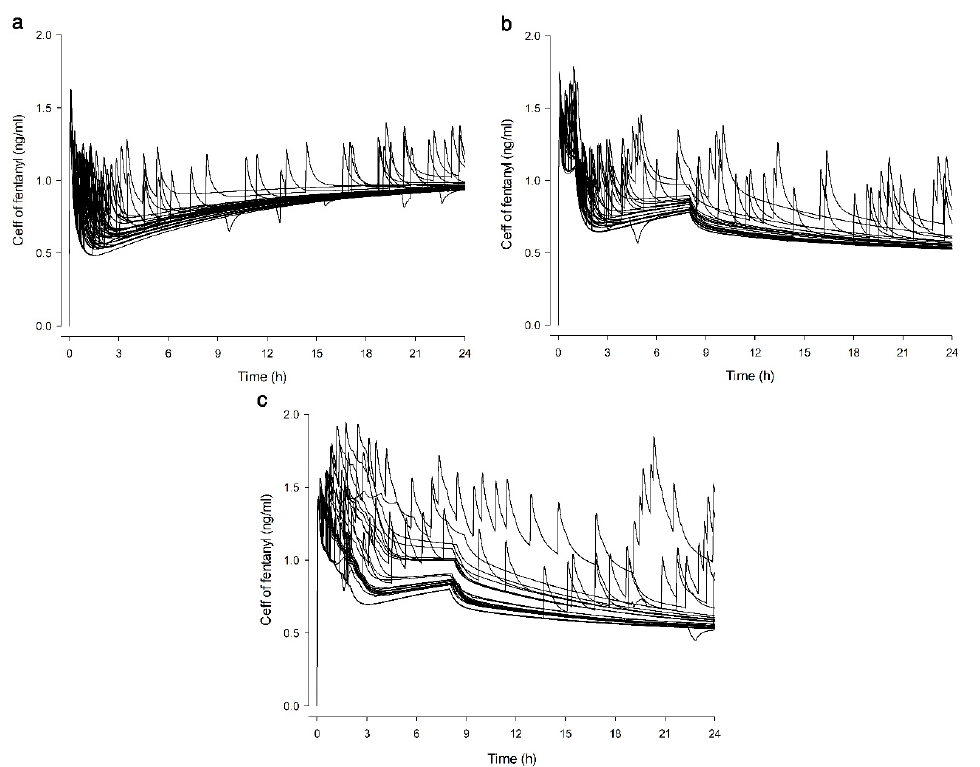
Figure 4. Time-courses of predicted e ff ect-site concentration (C e ff ) of fentanyl based on the infusion data stored in patient-controlled analgesia (PCA) infusers of actual patients in each group. Each peak represents the increased fentanyl C e ff by PCA demand-dose. ( a ) CRBI group, PCA with constant rate background infusion (BI). ( b ) TDBI group, fentanyl PCA with time-scheduled decremental BI. ( c ) POBI group, fentanyl PCA with PCA-optimised